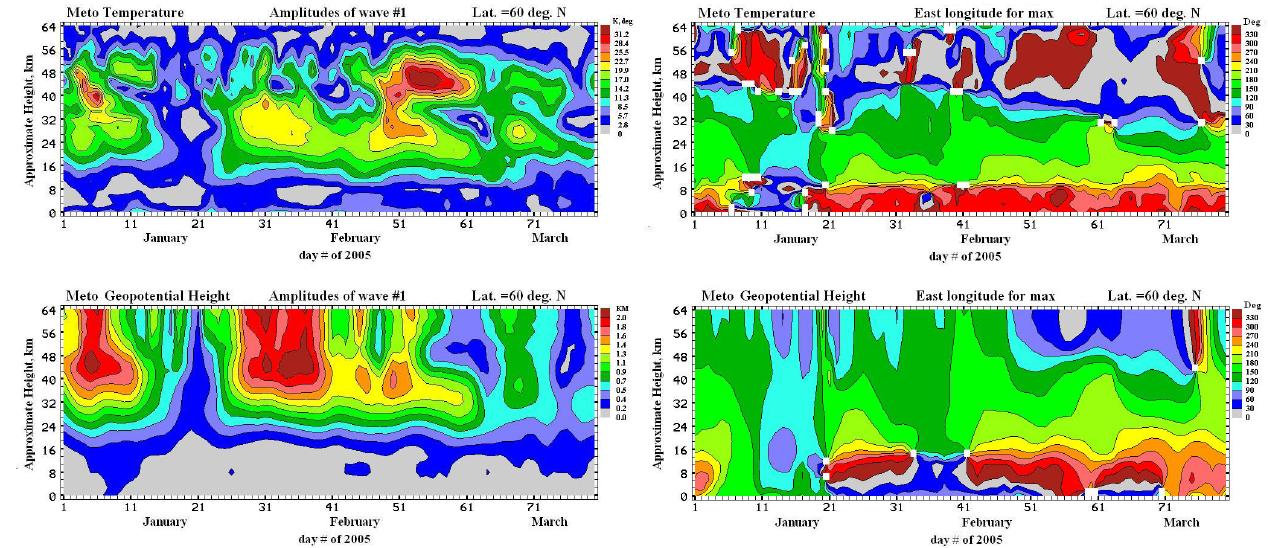
Fig. 2. Time (January–March) versus height ( ∼ 0–64km) contours of the amplitudes (left) and phases (right) of the wave number 1 tem- perature (top) and geopotential height (bottom) perturbations. The phase is defined as longitude (east of Greenwich meridian) of the wave